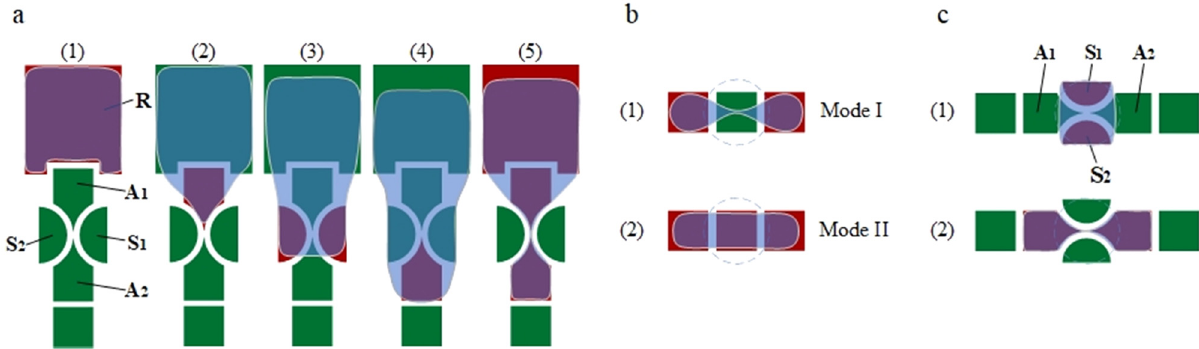
Figure 3: Electrode control mode in droplet dispensing and splitting schemes: ( a ) Optimized droplet dispensing scheme; ( b ) traditional droplet splitting scheme with square electrodes; ( c ) optimized droplet splitting